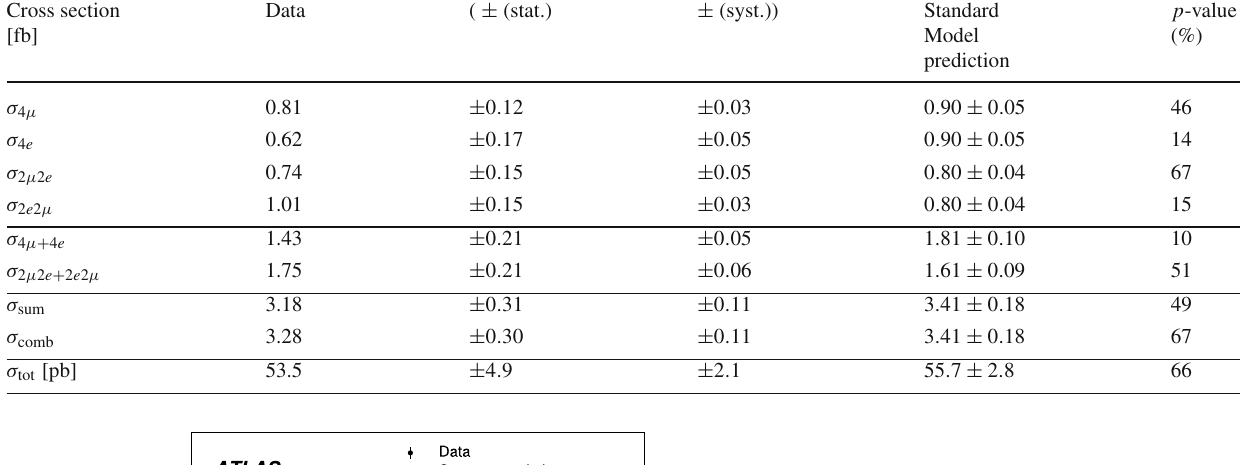
QCD and NLO EW for the ggF process. For the fiducial cross-section predictions, the SM cross sections are multiplied by the acceptances determined using the NNLOPS sample for ggF. For all the other pro- duction modes, the cross sections from the samples discussed in Sect. 3 are added. The p -values indicating the probability of compatibility of the measurement and the SM prediction are shown as well. They do not include the systematic uncertainty in the theoretical predictions